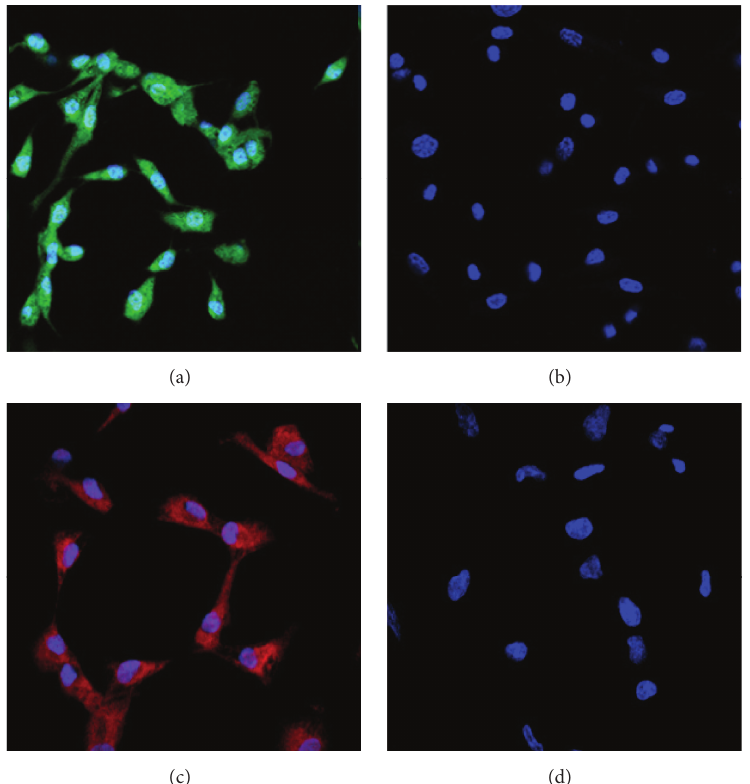
Figure 1: Confocal images of cultured human RMECs. (a) Immunofluorescent staining of vWF with sheep polyclonal antibody (Abcam). (b) Negative control of vWF identification. (c) Immunofluorescent staining of CD31 with mouse monoclonal antibody (Abcam). (d) Negative control of CD31 identification.